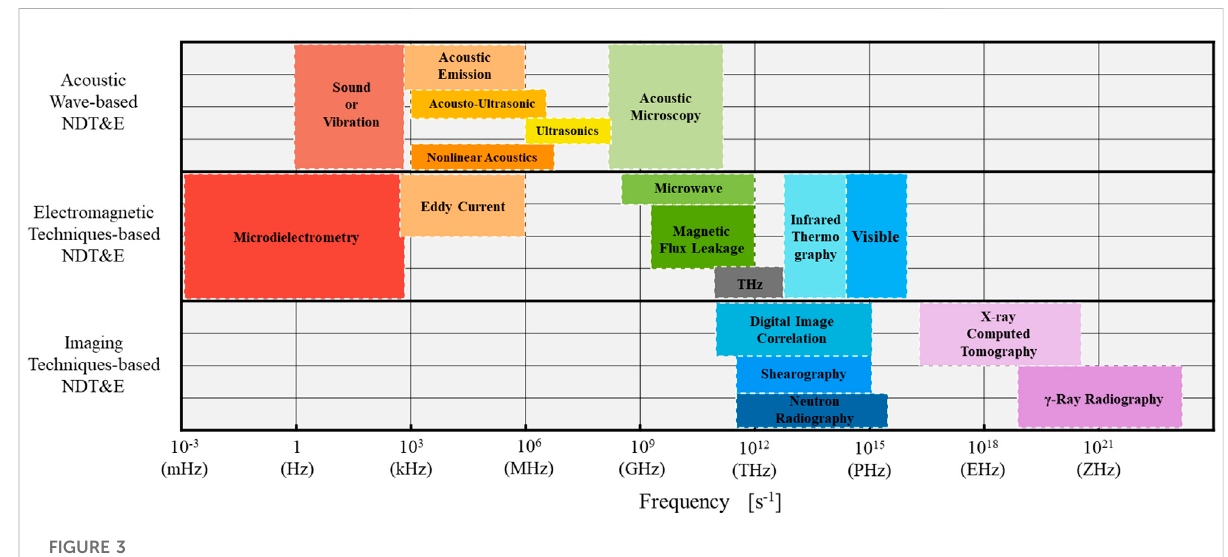
FIGURE 3 Classi fi cation of different NDT&E technologies in the frequency